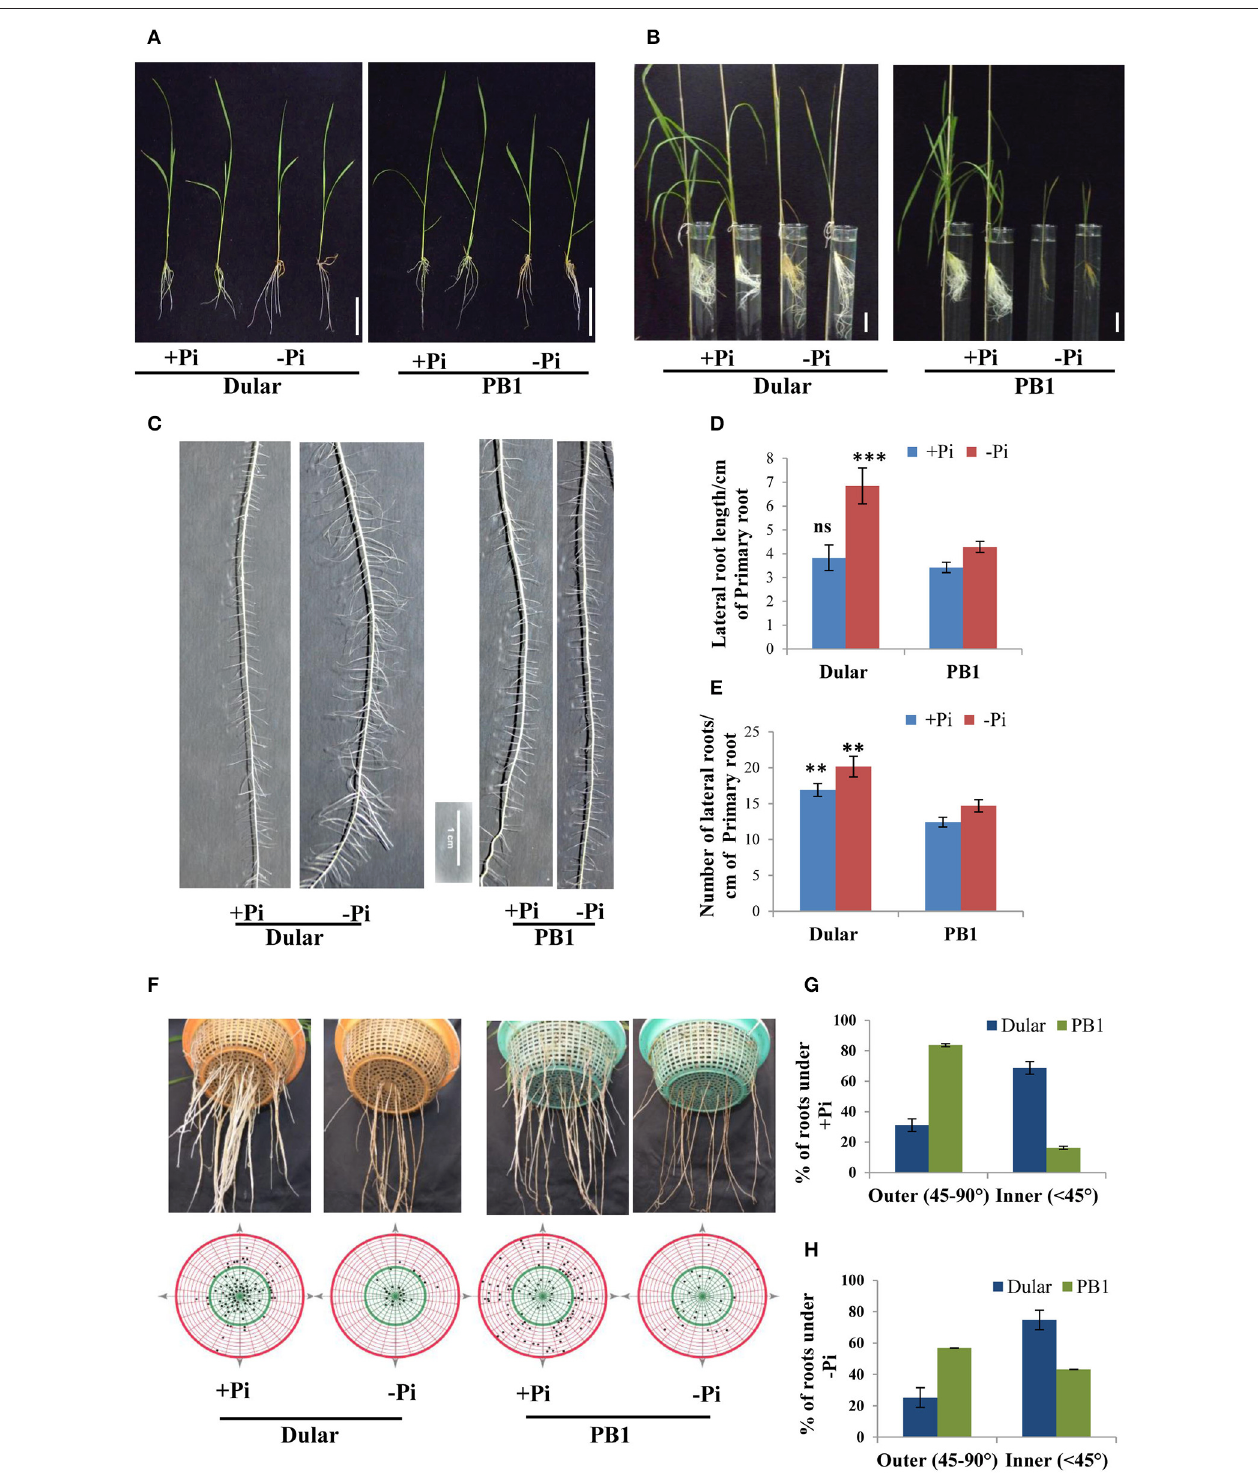
FIGURE 1 | Differential plant growth under Pi deficiency (A) Seedling growth of hydroponically grown Dular and PB1 raised under Pi sufficient (320 µ M) and Pi deficient (1 µ M) conditions in hydroponics after 15-days and (B) two-month. (C) Lateral root phenotype; (D) length and (E) density of PB1 and Dular under + Pi and − Pi. (F) Root spread of PB1 and Dular under + Pi and − Pi condition. Lower panel shows points of root emergence from the side and bottom of basket. (G) Percentage of roots emerging from side (outer) and bottom (inner) regions of basket under + Pi and (H) − Pi. Scale bar = 5cm. ** p < 0.01; *** p < 0.001; ns not significant as determined by student’s t